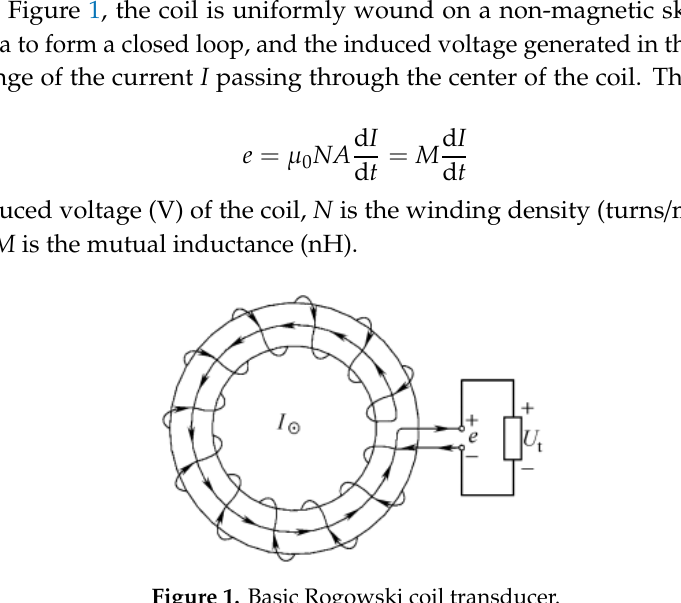
Figure 1. Basic Rogowski coil transducer.